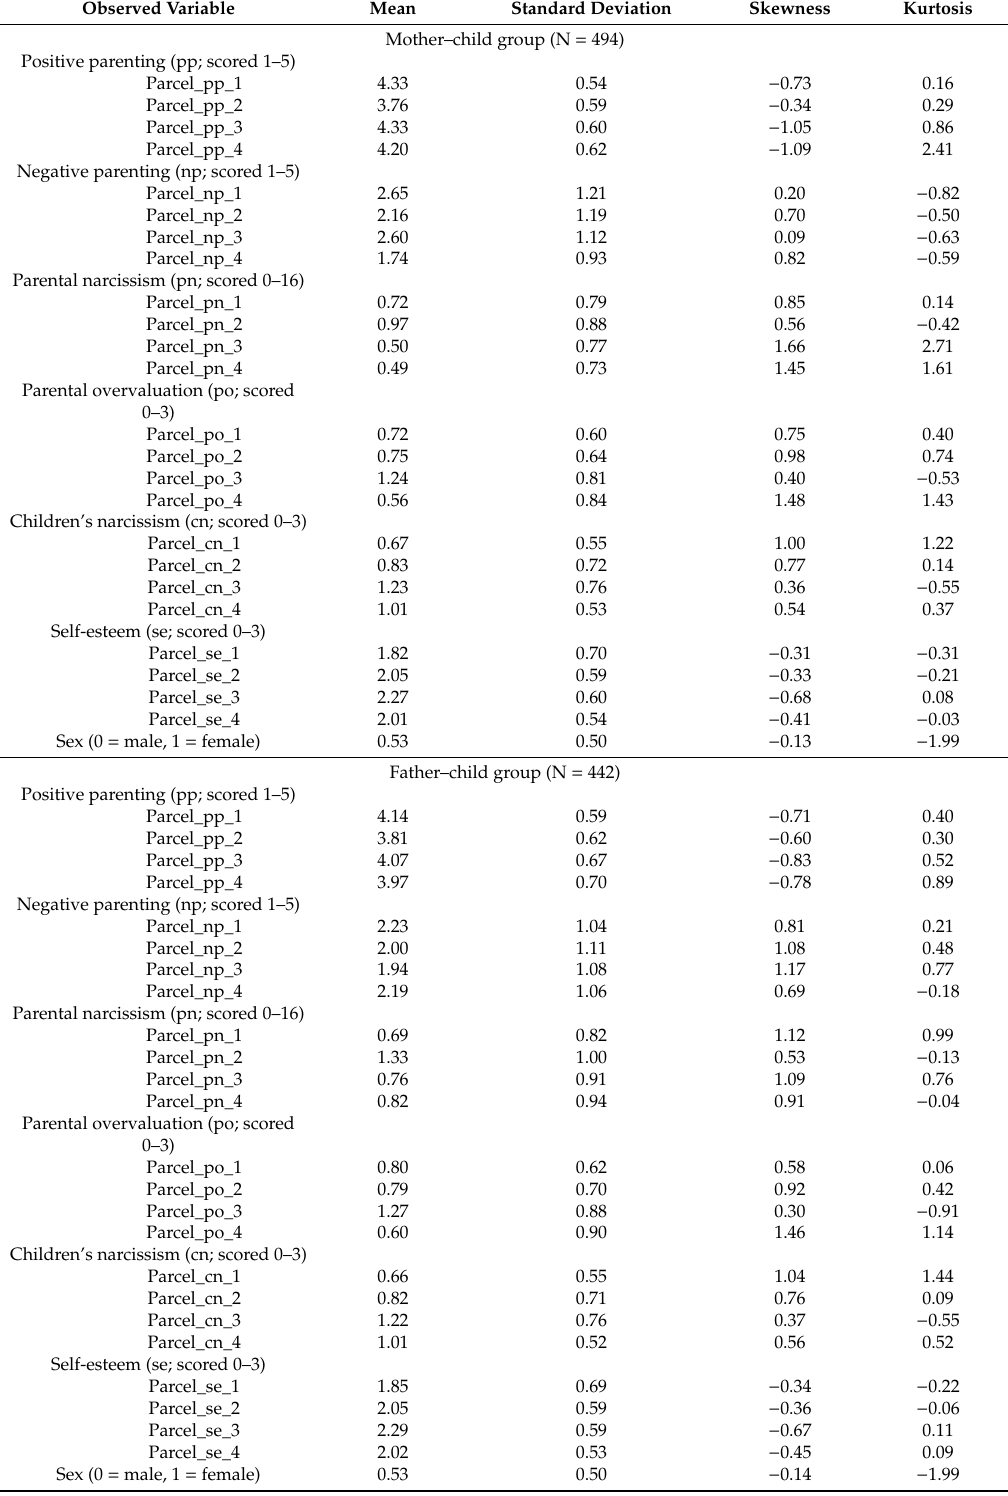
Table 1. Mean scores, standard deviations, skewness, and kurtosis of the observed variables for the mother–child and father–child